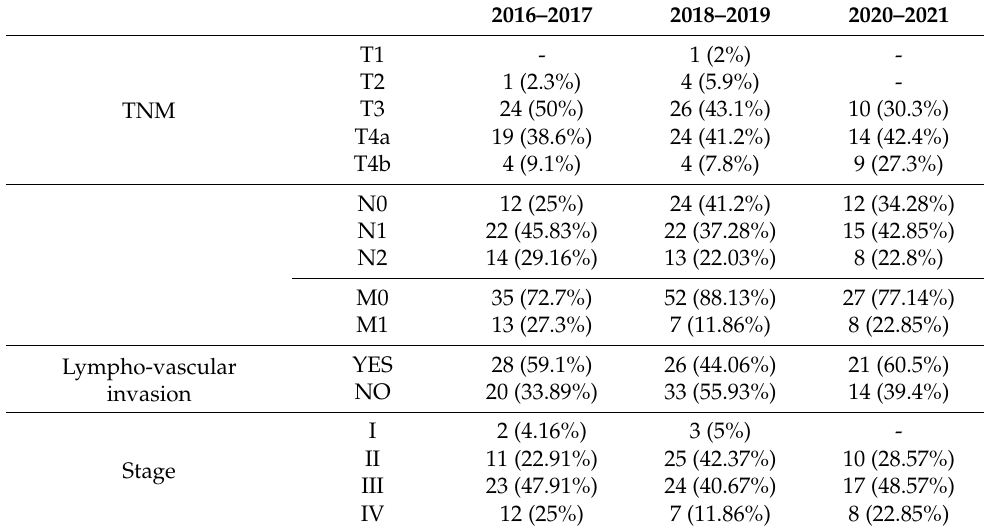
Table 3. TNM variation, presence of lympho-vascular invasion and the stage during the three periods of the